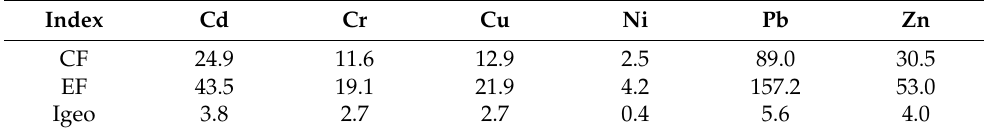
Table 3. Madrid environmental pollution